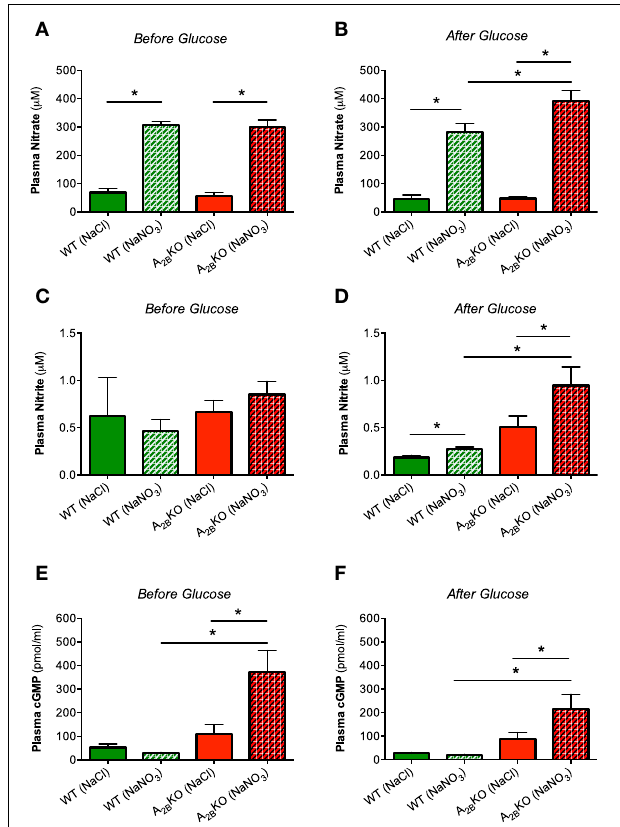
FIGURE 4 | Nitrate, nitrite and cGMP in plasma. Treatment with nitrate significantly increased plasma levels of nitrate in both genotypes before (A) and after glucose injection (B) . Plasma nitrite levels were significantly increased only in nitrate treated A 2B KO mice after glucose (C, D) . In A 2B KO mice, nitrate supplementation caused a significant increase of plasma cGMP levels both before (E) and after glucose injection (F) . Values are mean ± SEM, n = 6 –14/group. * p < 0 . 05 among the indicated